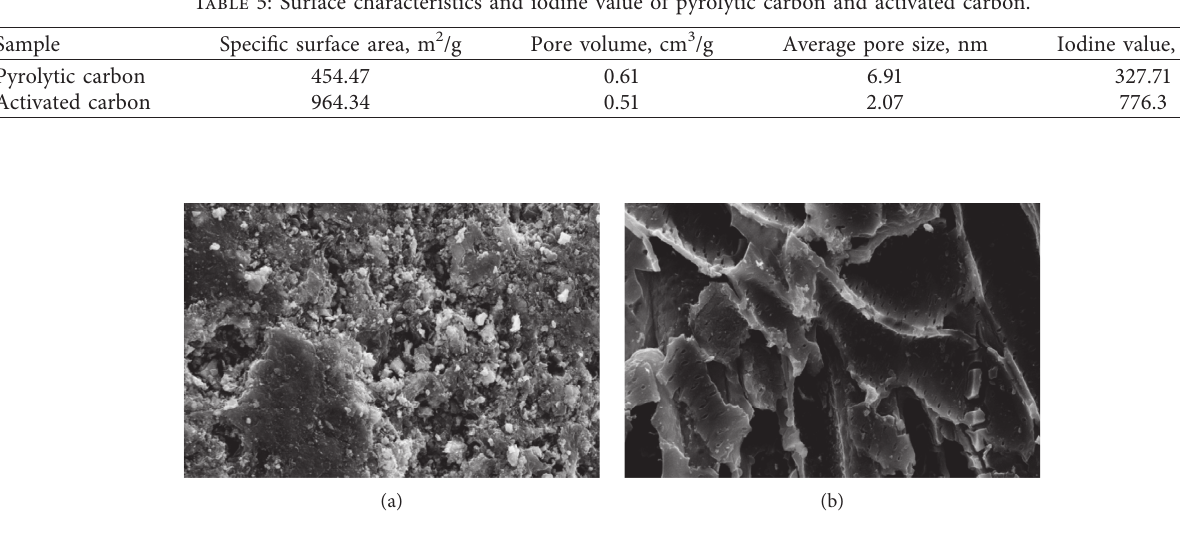
Figure 1: SEM images of (a) pyrolytic carbon and (b) activated carbon.